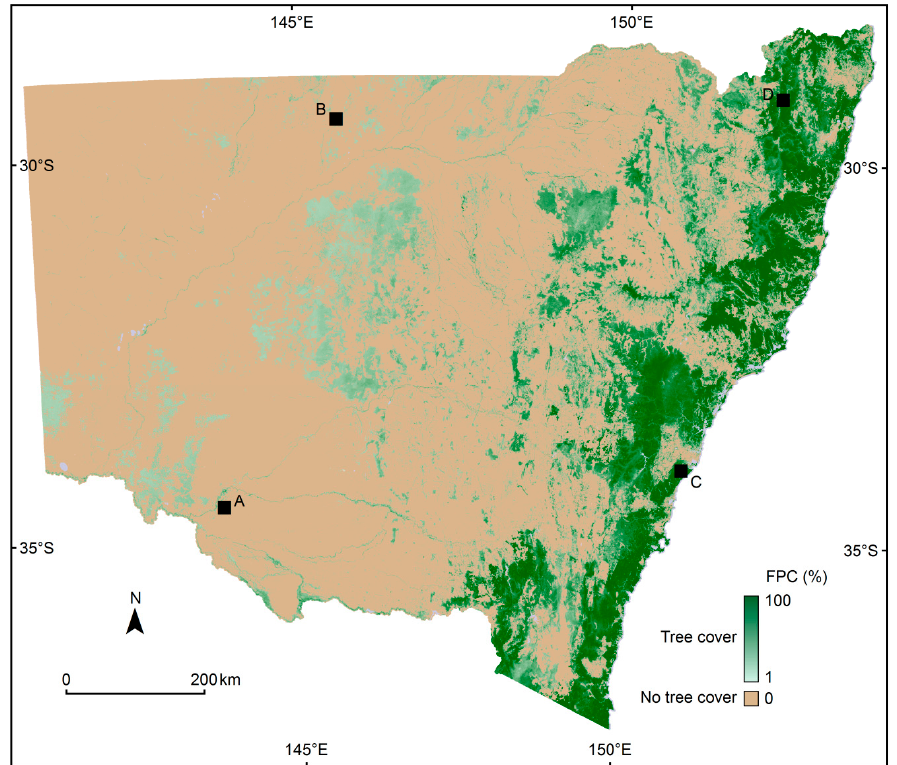
Figure 6. The final 5 m foliage projective cover (FPC) map for New South Wales, Australia.